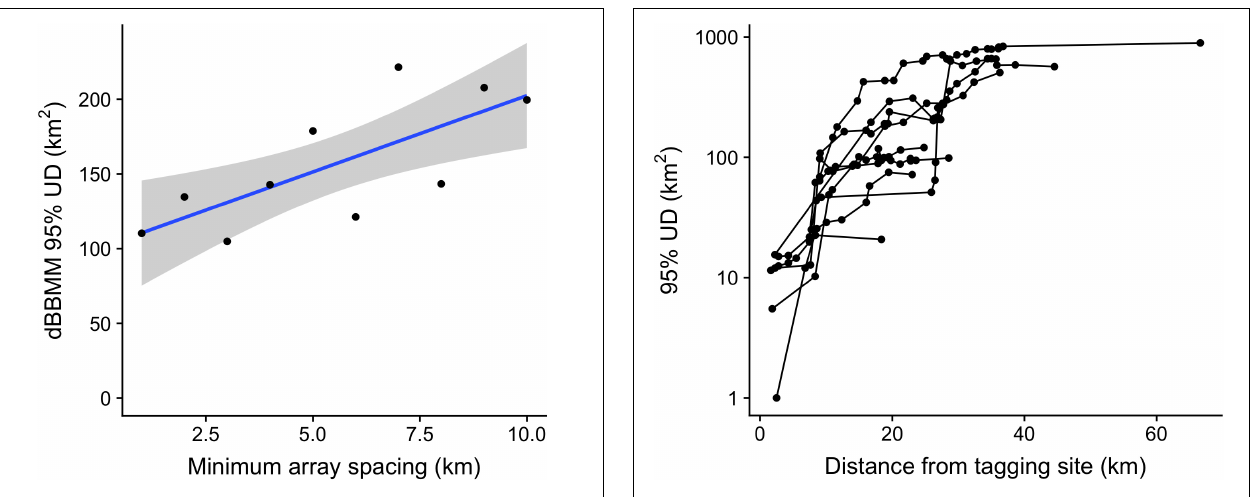
FIGURE 9 | Cumulative 95% KUDs of nine Silvertip Sharks, relative to distance from tagging site based on dBBMM. Sequentially adding data from receivers in order of their distance from a shark’s tagging